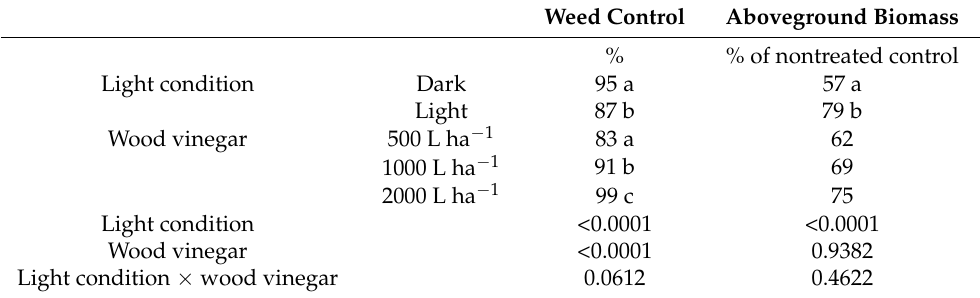
Table 3. Common purslane control following wood vinegar application at 5